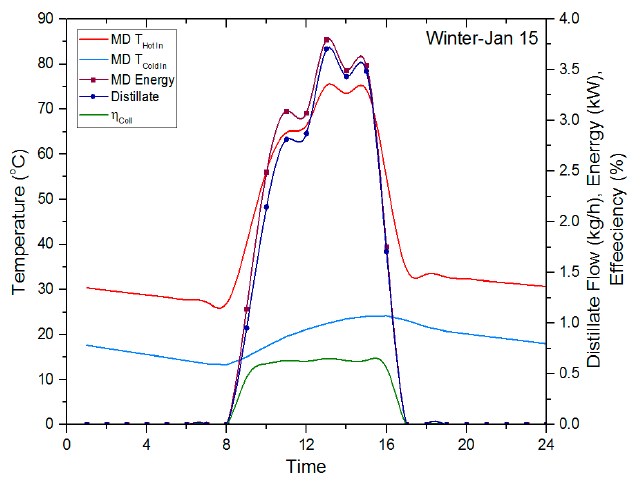
Figure 8. Summer and winter operation of Solar Membrane Distillation (SMD).